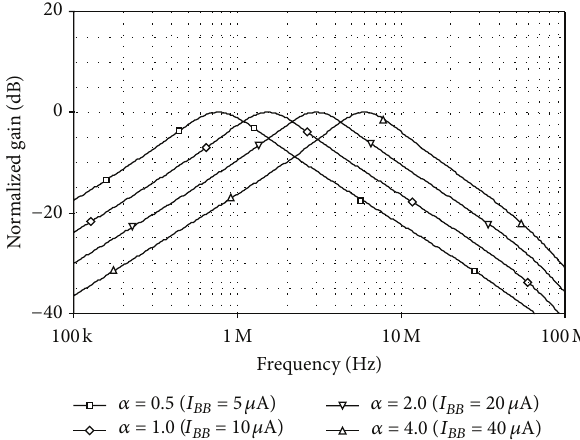
Figure 15: Simulated BP responses for different values of 𝐼 𝐵𝐵 .